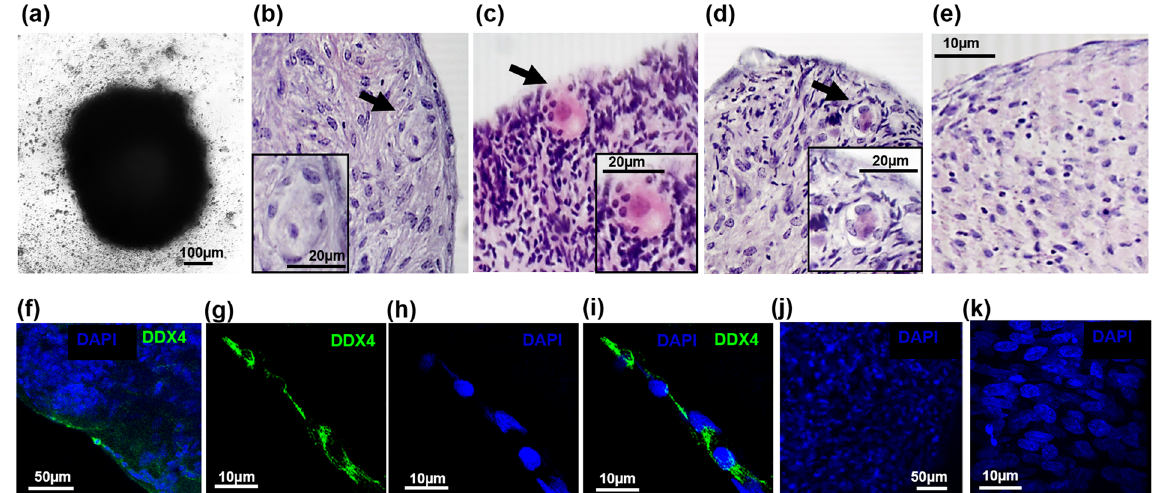
Figure 5. Images of aggregates formed from DDX4-positive cells and fetal ovarian derived somatic cells (FODSCs). Defined aggregates are formed within 10 days ( a ). Histological sections of the aggregates stained with Haematoxylin and Eosin (H&E) show the formation of follicle like structures ( b – d ). These comprised of a large oocyte-like eosin stained cell with a nuclear structure surrounded by somatic cells (inserts b – d ). 1–3 follicle like structures were observed per aggregate in 57% of aggregates where they were found close to the edges ( b – d ). No structures were observed in any aggregates comprised of FODSCs alone ( e ). x20 magnification, scale bars, 100 µ m, 20 µ m and 10 µ m. Confocal imaging showed the presence of DDX4-positive cells (green) within aggregates ( f – i ) when immunostained for DDX4 using ab13840. Low power magnification (X20) ( f ) shows staining for DDX4 (green) close to the edges of the aggregates with surrounding cells staining positive for DAPI (blue) only. High power magnification (X63; g – i ) of the DDX4-positive stained cells shows elongated cells with DDX4 staining predominantly in the cytoplasm and cell membrane (green, g ) with the nucleus staining positive for DAPI ( h ); merged images ( i ). No DDX4-positive cells were observed in aggregates comprised of FODSCs alone ( j , k DAPI staining (blue) used for cellular visualisation). X20 magnification, scale bar 50 µ m. x63 magnification, scale bar 10 µ m.